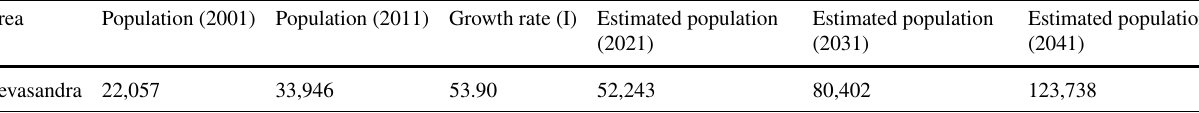
Table 1 Forecasted population details for Devasandra ward